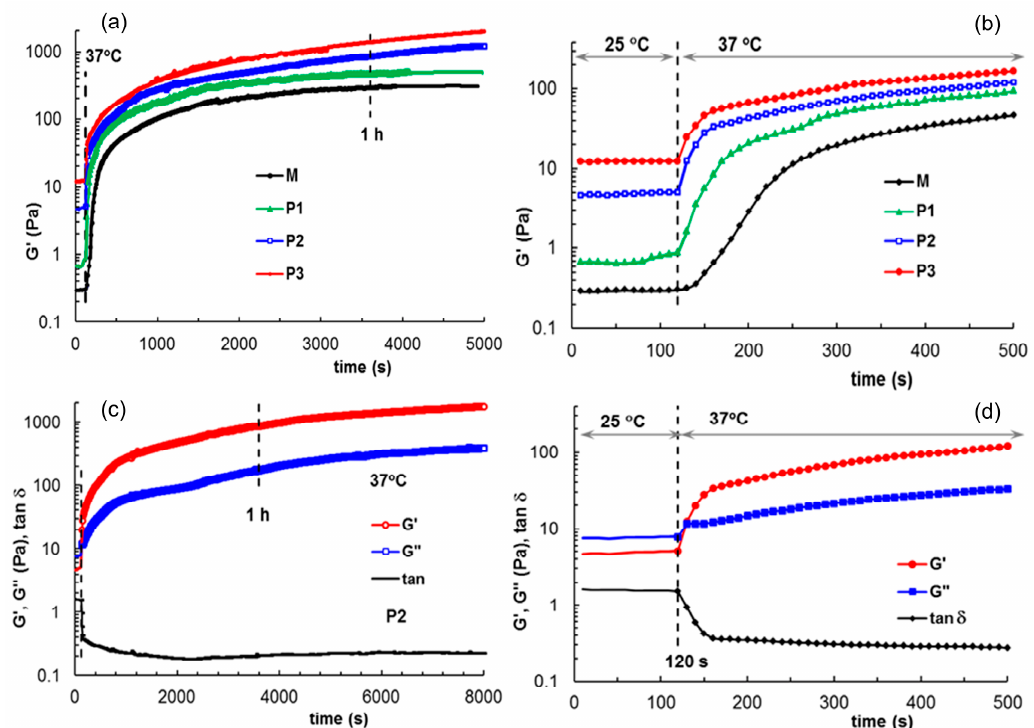
Figure 7. ( a , b ) Evolution of G’ during gelation at 37 °C for all investigated samples; ( c , d ) Viscoelastic parameters G’, G” and tan δ during gelation for sample P2. The samples were first tested at 25 °C for 120 s, then the temperature was suddenly switched to 37 °C, and in situ gelation was monitored through the rheological parameters. ( b , d ) detail the behavior of the systems at the beginning of gelation.